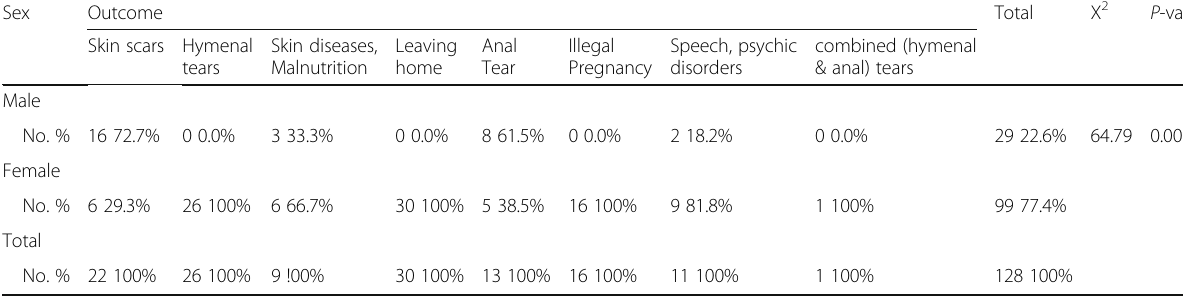
Table 7 Relation between gender and outcome among the studied cases Sex Outcome Total X 2 P -value Skin scars Hymenal Skin diseases, Leaving Anal Illegal Speech, psychic combined (hymenal tears Malnutrition home Tear Pregnancy disorders & anal)